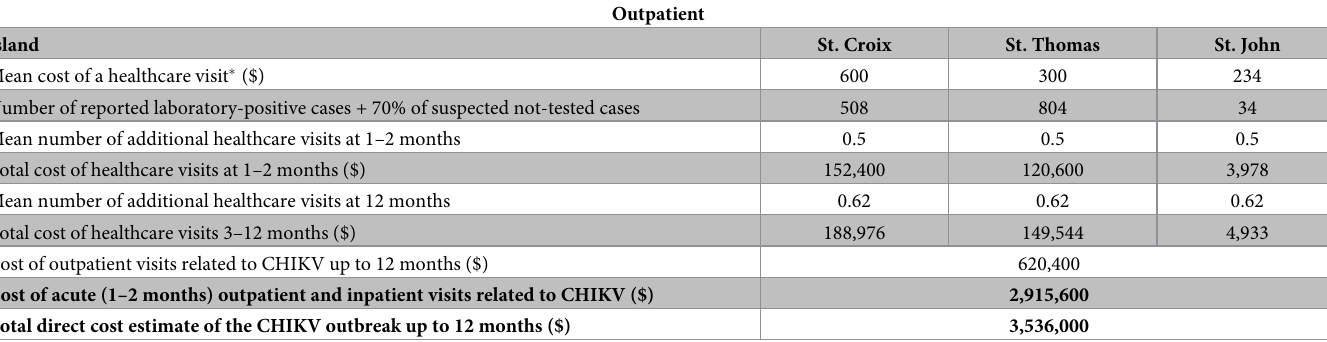
Table 4. Direct cost estimate (2014 USD) of the chikungunya outbreak in the U.S. Virgin Islands up to 12 months after illness onset.